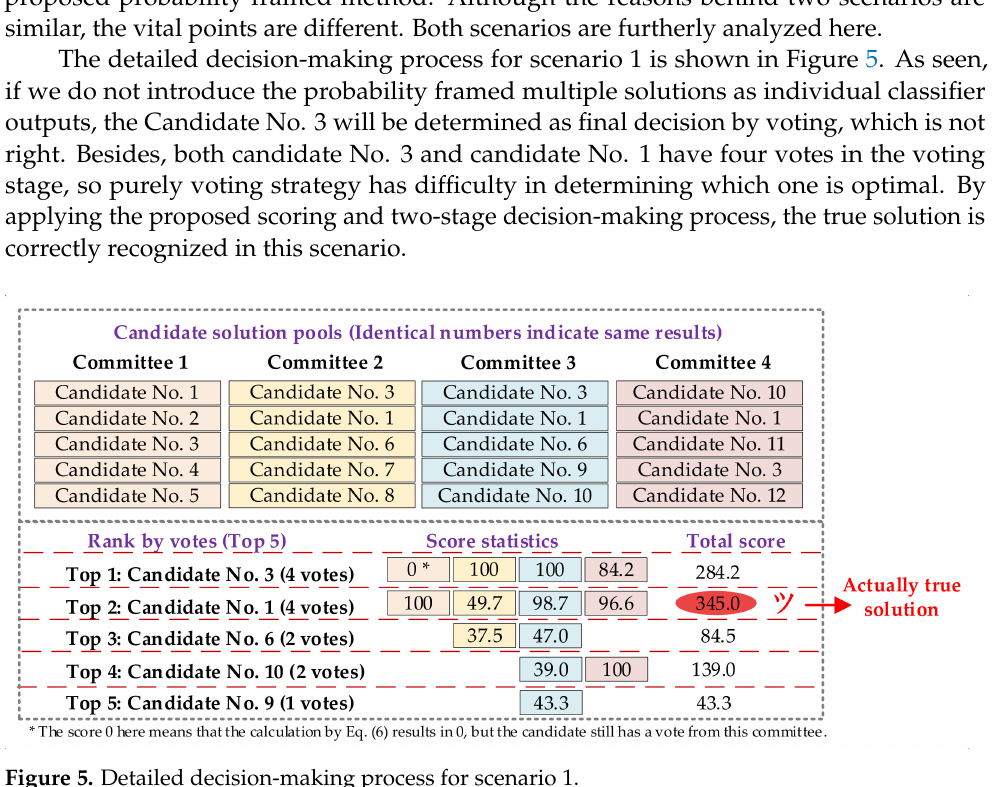
Figure 5. Detailed decision-making process for scenario